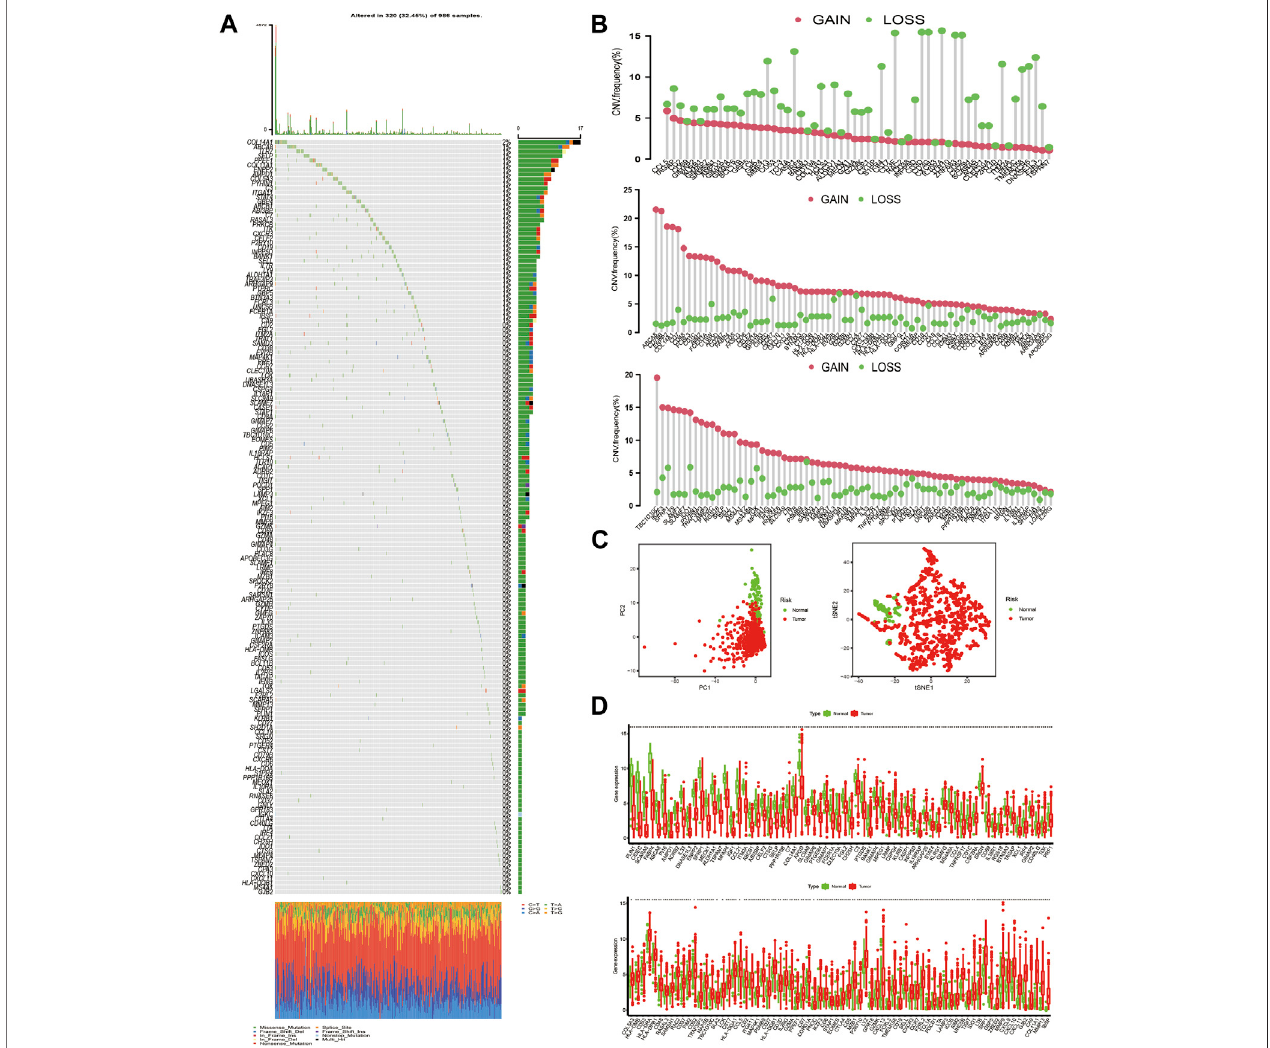
FIGURE 3 | The landscape of genetic alteration of differentially expressed genes in breast cancer. (A) 320 of the 986 BC samples experienced genetic alterations, mostly including missensemutation, nonsense mutation, and splice site mutation. The number on theright indicated the mutation frequencyof each DEG. Each column represented the individual BC sample. (B) The CNV mutation frequency of DEGs was prevalent. The column represented the alteration frequency. The ampli fi cation frequency, pink dot; the deletion frequency, green dot. Because of the size of the gene list (205 genes), we presented the CNV results in 3 plots: one for CNV deletionandtheothertwoforampli fi edCNV. (C) PCAandt-SNEanalysisbasedontheexpressionofDEGstodistinguishBCsamples(reddots)fromnormalones(green dots). (D) The differences in mRNA expression level of DEGs between tumor and normal samples was compared by R “ limma ” package. The asterisks represented the statistical p -value (* p < 0.05; ** p < 0.01; *** p < 0.001). For graphical reasons, we presented the gene lists (upregulated and downregulated genes in BC samples) in 2 plots and ordered them based on the log